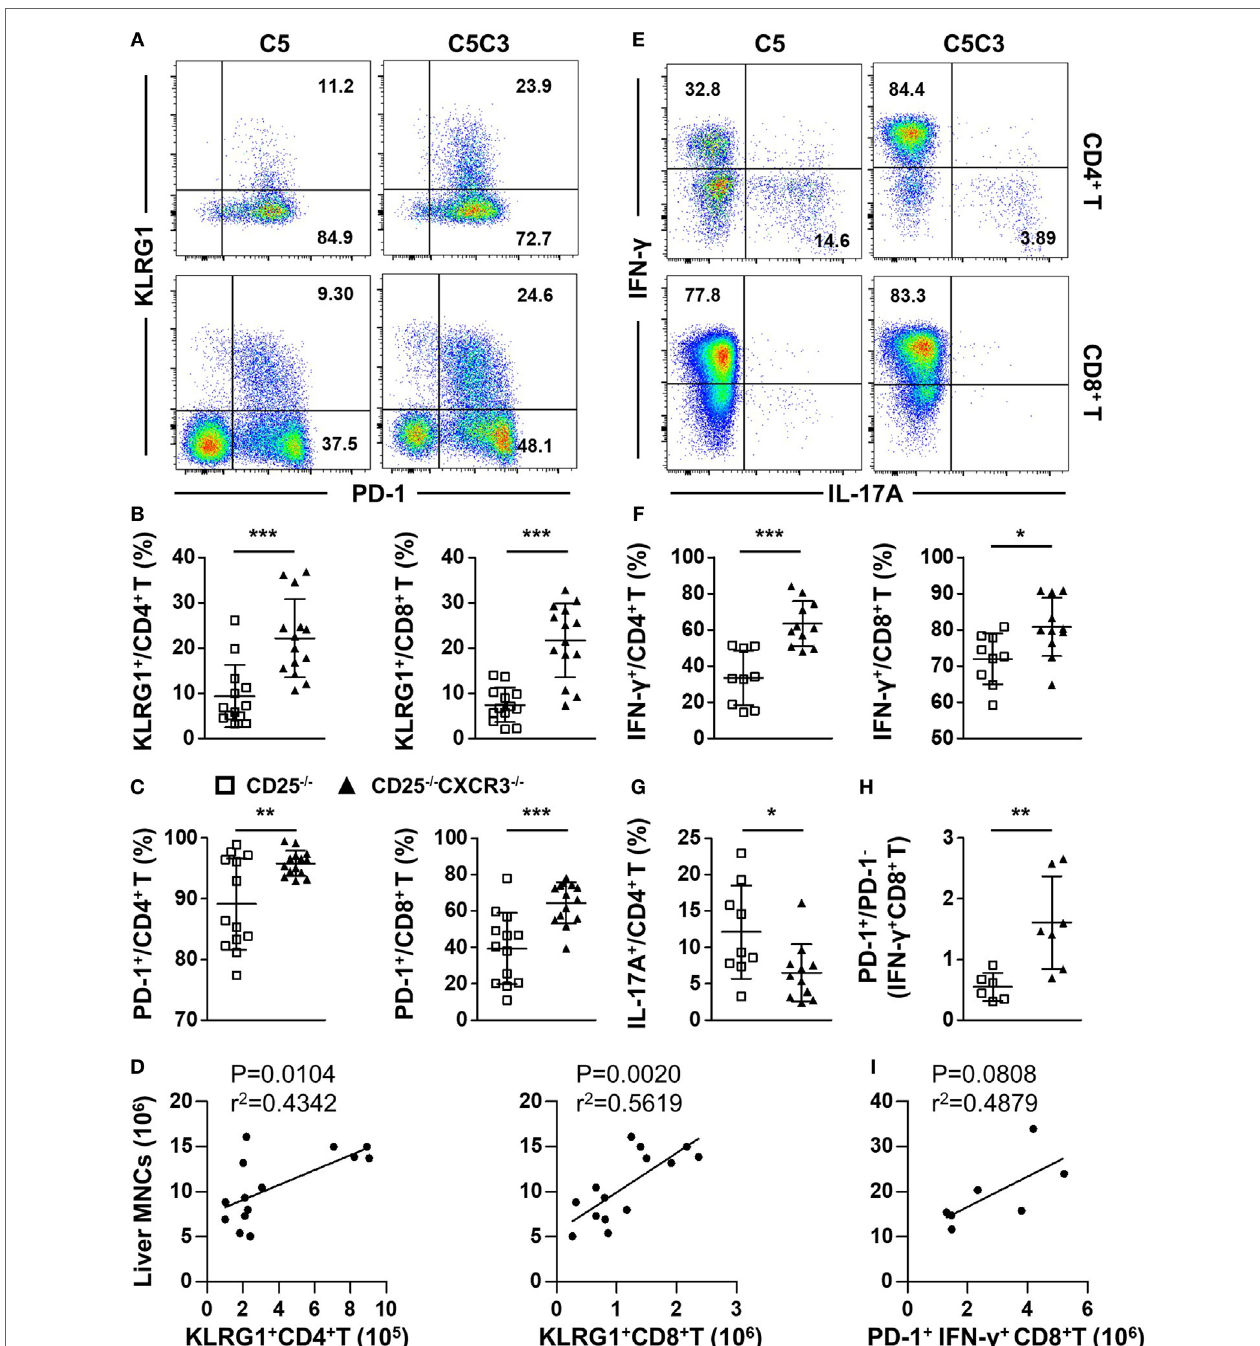
FigUre 5 | Effects of CXC chemokine receptor 3 (CXCR3) deletion on T cell exhaustion markers and pro-inflammatory factors in liver of CD25 − / − mice. The phenotypes of T cell subsets in the CD25 − / − and CD25 − / − CXCR3 − / − mice were analyzed with flow cytometry. (a) Representative flow cytometry dot plots of hepatic CD4 + and CD8 + T cells stained for PD-1 and KLRG1. (B) Percentage of KLRG1 + cells in hepatic CD4 + T and CD8 + T populations of CD25 − / − mice ( N = 13) and CD25 − / − CXCR3 − / − mice ( N = 14). (c) Percentage of CD-1 + cells in hepatic CD4 + T and CD8 + T populations of CD25 − / − mice ( N = 13) and CD25 − / − CXCR3 − / − mice ( N = 14). (D) The correlation analysis between liver mononuclear cells (MNCs) and hepatic KLRG1 + CD4 + T and KLRG1 + CD8 + T cells from CD25 − / − CXCR3 − / − mice ( N = 14). (e) Representative flow cytometry dot plots of hepatic CD4 + and CD8 + T cells stained for intracellular cytokines interferon (IFN)- γ and interleukin (IL)-17A. (F) Percentages of IFN- γ -producing CD4 + T and CD8 + T cells in liver of CD25 − / − mice ( N = 9) and CD25 − / − CXCR3 − / − mice ( N = 11). (g) Percentage of IL-17A- producing CD4 + T cells in liver of CD25 − / − mice ( N = 9) and CD25 − / − CXCR3 − / − mice ( N = 11). (h) PD-1 + /PD-1 − ratio in IFN- γ -producing hepatic CD8 + T cells compared between CD25 − / − mice ( N = 6) and CD25 − / − CXCR3 − / − mice ( N = 7). (i) The correlation analysis between liver MNCs and hepatic PD-1 + IFN- γ + CD4 + T cells from CD25 − / − CXCR3 − / − mice ( N = 7). * p < 0.05; ** p < 0.01; *** p < 0.001. C5, CD25 − / − mice; C5C3, CD25 − / − CXCR3 − / −